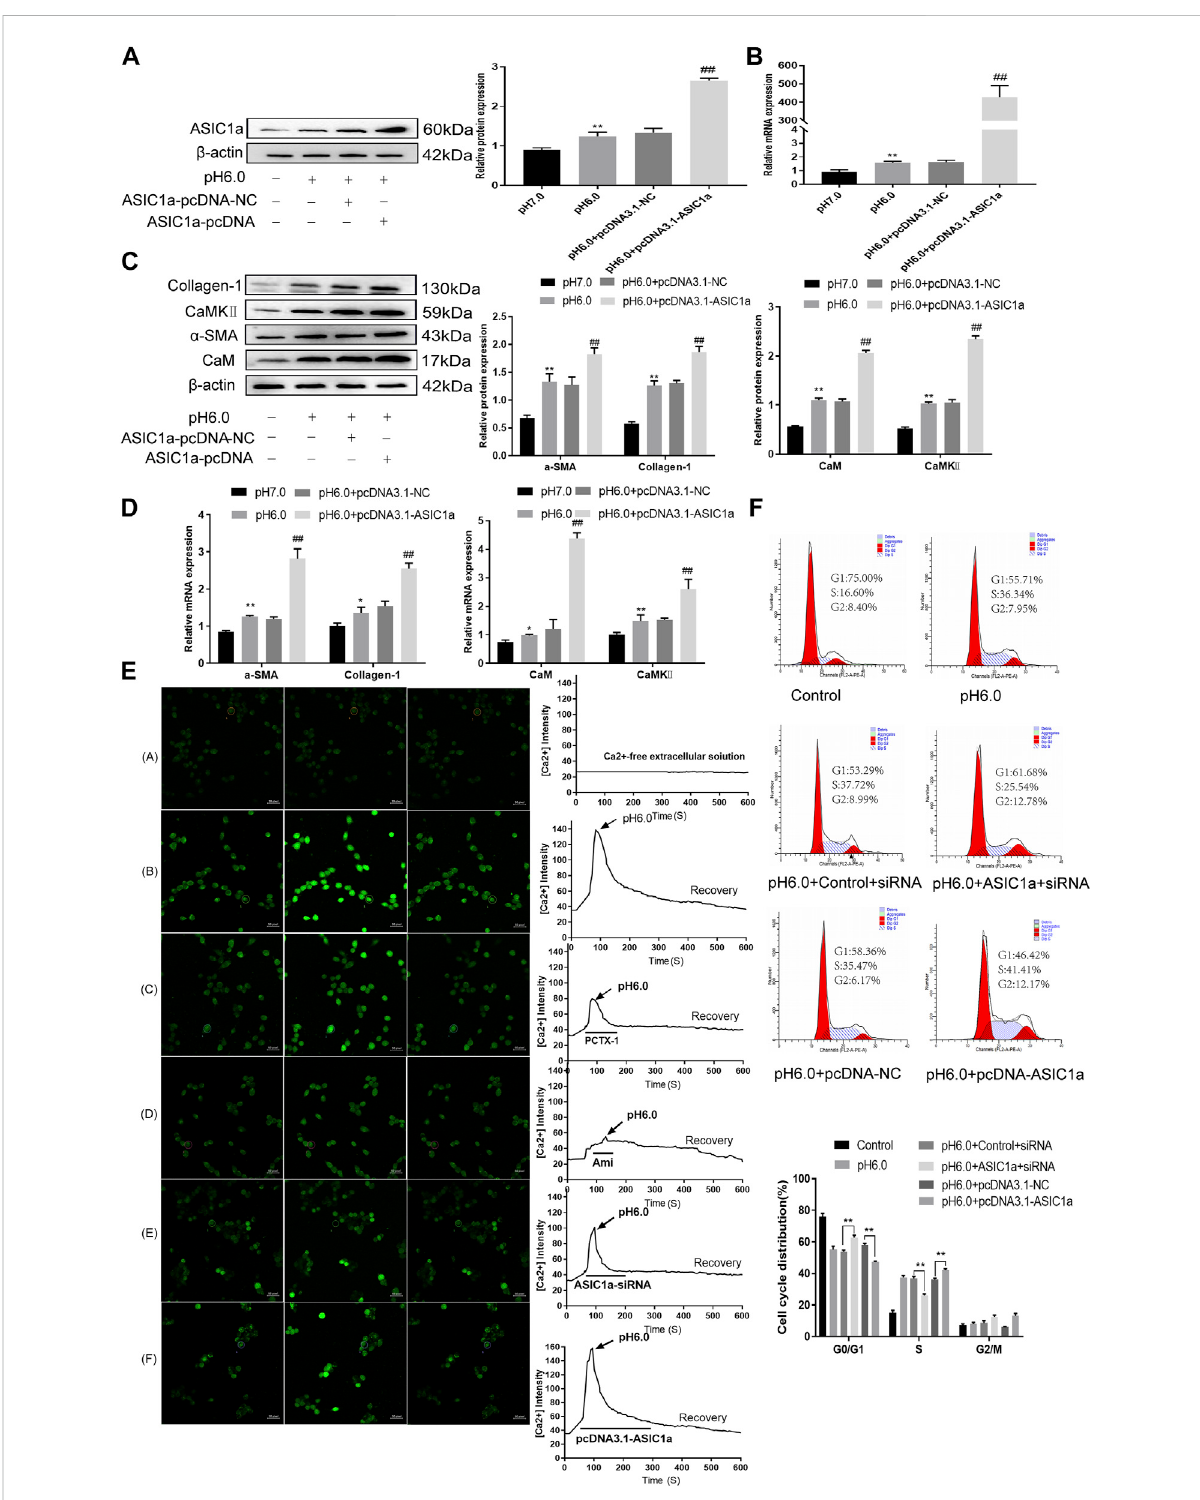
The expression of CaM/CaMK Ⅱ was detected in HSC-T6 cells regulated by ASIC1a. (A) The level of ASIC1a protein in HSCs was detected by WesternblottingafteroverexpressionofASIC1a. (B) ThemRNAlevelofASIC1ainHSCswasdetectedbyqRT-PCRafteroverexpressionofASIC1a. (C) The expression of CaM, CaMK Ⅱ and fi brosis protein in HSCs was detected by Western blotting after overexpression of ASIC1a. (D) After overexpression of ASIC1a, qRT-PCR was used to detect the level of mRNA of CaM, Cam KII and fi brosis protein in HSCs. (E) After ASIC1a was silenced or overexpressed, the effect of HSCs cells cycle was detected by fl ow cytometry. (F) Laser confocal scanning (Scale Bar, 50 μ m) to detect the effect of ASIC1a on Ca 2+ concentration in HSCs. (Scale Bar, 50 µM).Data are expressed as the mean ± SD ( n ≥ 3). * p < .05, ** p < .01 vs. Control group; # p < .05, ## p < .01 vs. pH 6.0